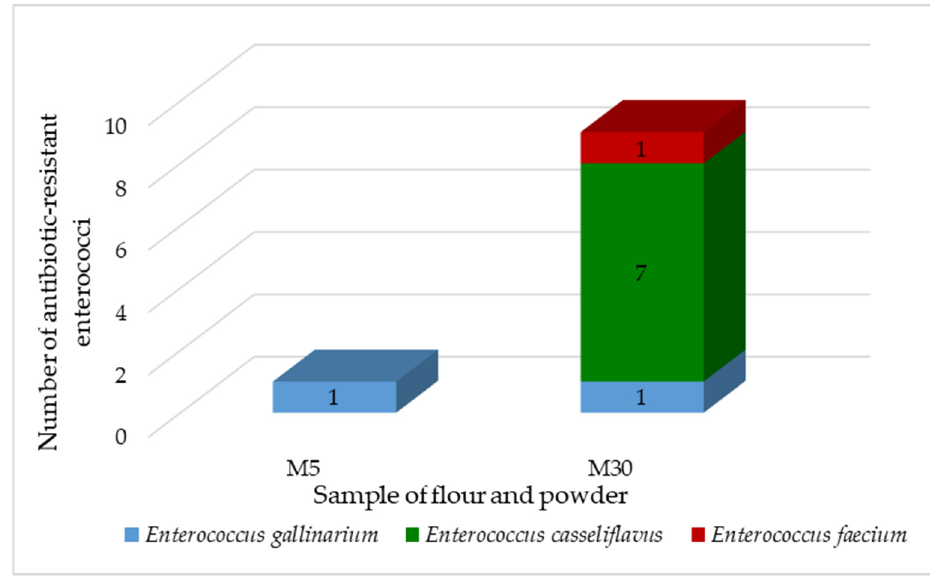
Figure 2. Antibiotic-resistant enterococci isolated from flour, powder. M5—Amarant, M30—Coconut.